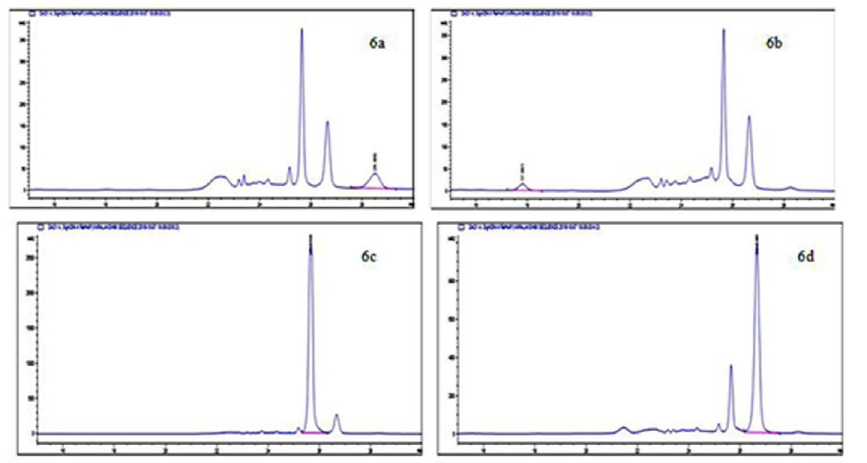
Fig. 6. HPLC Chromatogram of BAs produced by E. cloacae showing a peak of histamine (6a), tyramine (6b), putrescine (6c) and cadaverine